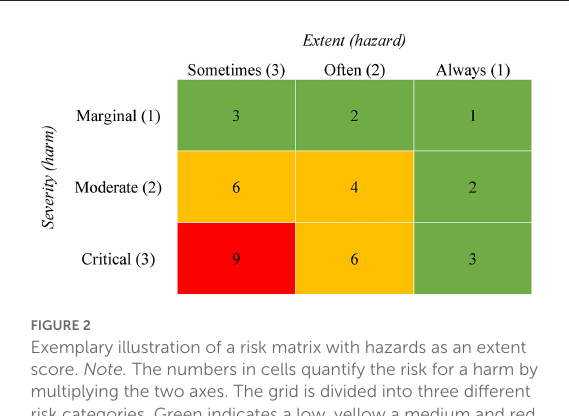
FIGURE2 Exemplary illustration of a risk matrix with hazards as an extent score. Note. The numbers in cells quantify the risk for a harm by multiplying the two axes. The grid is divided into three different risk categories. Green indicates a low, yellow a medium and red a high